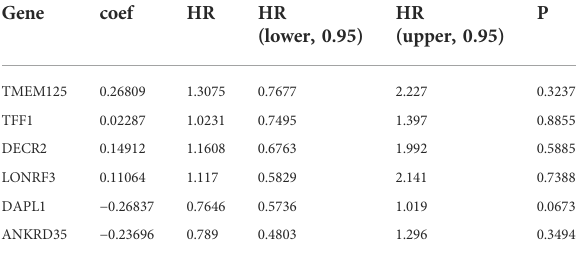
TABLE 1 Multivariate cox regression results in the training